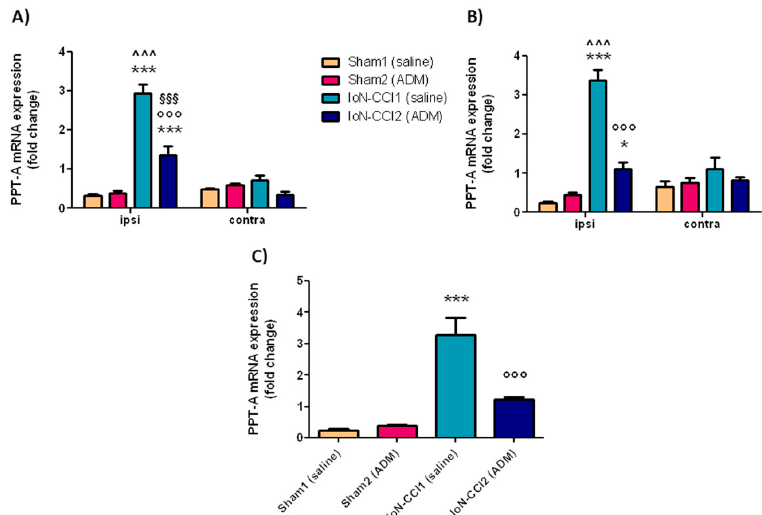
Figure 5. PPT-A mRNA expression in TGs ( A ), CSC ( B ), and medulla ( C ). Data is expressed as mean + SEM. One way analysis of variance (ANOVA) followed by Tukey’s Multiple Comparison Test or Two-way ANOVA followed by Bonferroni post-hoc test, * p < 0.05 and *** p < 0.001 vs. Sham1 and Sham2 groups (ipsi), °°° p < 0.001 vs. IoN-CCI1 group (ipsi), ^^^ p < 0.001 vs. IoN-CCI1 group (contra), §§§ p < 0.001 vs. IoN-CCI2 (contra).